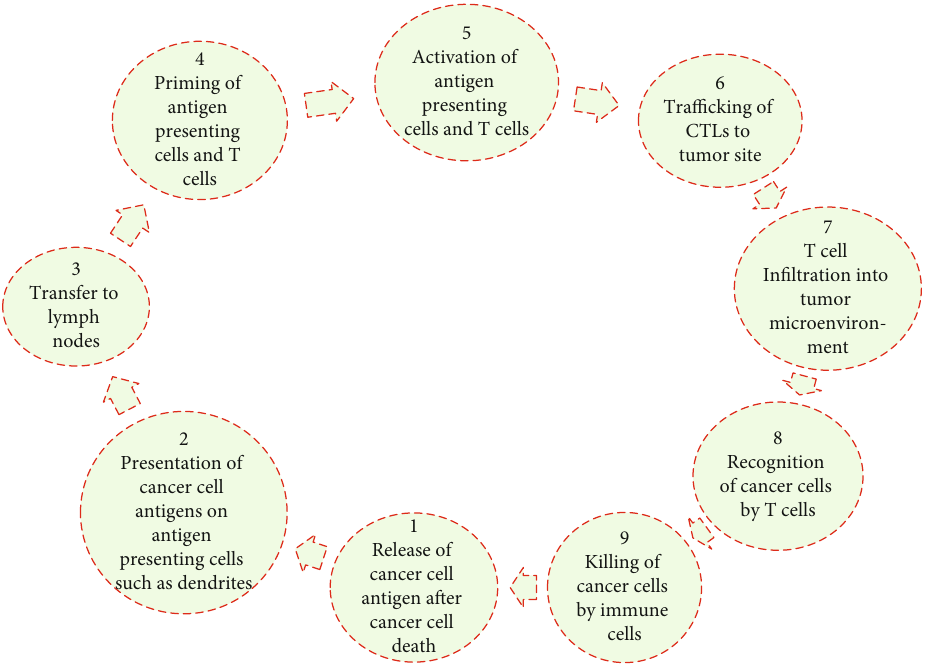
Figure 2: Cancer-immunity cycle showing its main stages such as release, presentation, transfer, priming, activation, tra ffi cking, in fi ltration, recognition, and killing.